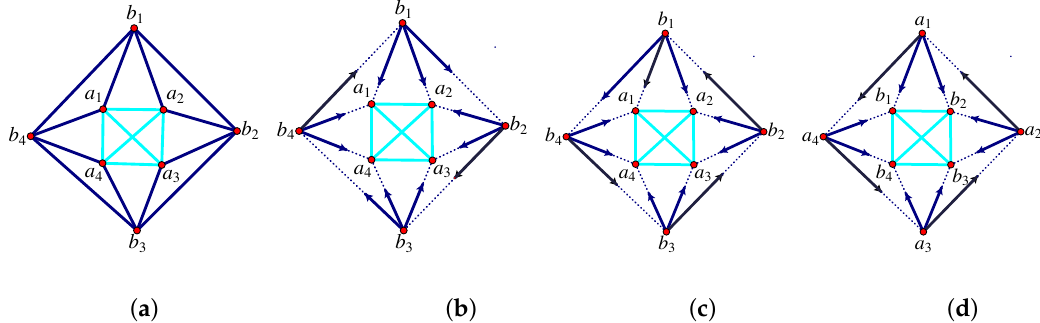
Figure 29. The isostatic graph in ( a ) has a generically rigid tetrahedron (aqua coloured edges) whose factor we know. With that tied down, the remaining edges have two 3-directed orientations ( b , c ) which each give a term summing to the remaining pure condition. If we swap the placement of the tetrahedron ( d ), we get a related pure